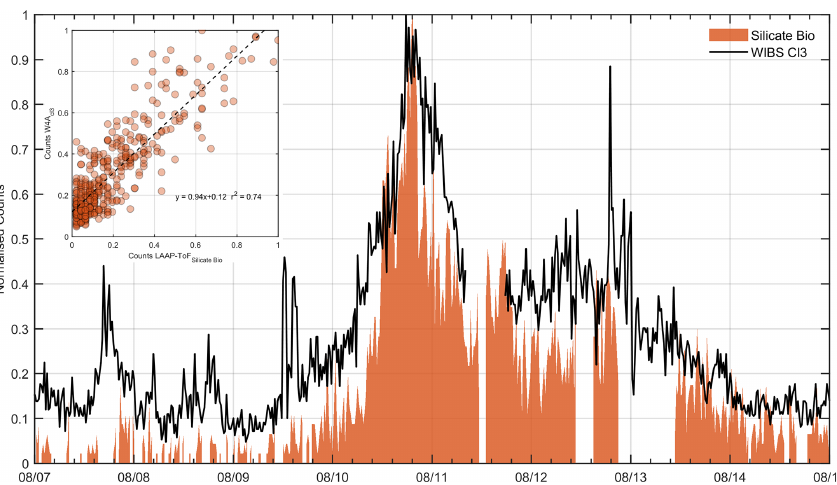
Figure 9. Time series of WIBS Cluster 3 and silicate dust filtered for biomarkers using 20min averaged number counts normalised by the maximum observed concentration for each instrument. Values for the inset plot are also normalised to the maximum observed